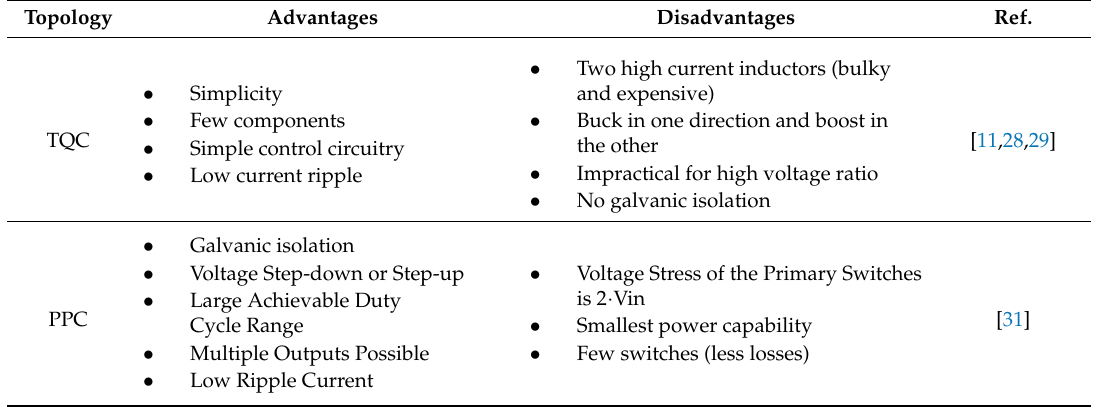
Table 5. Comparison of DC-DC Converters for LV-Battery